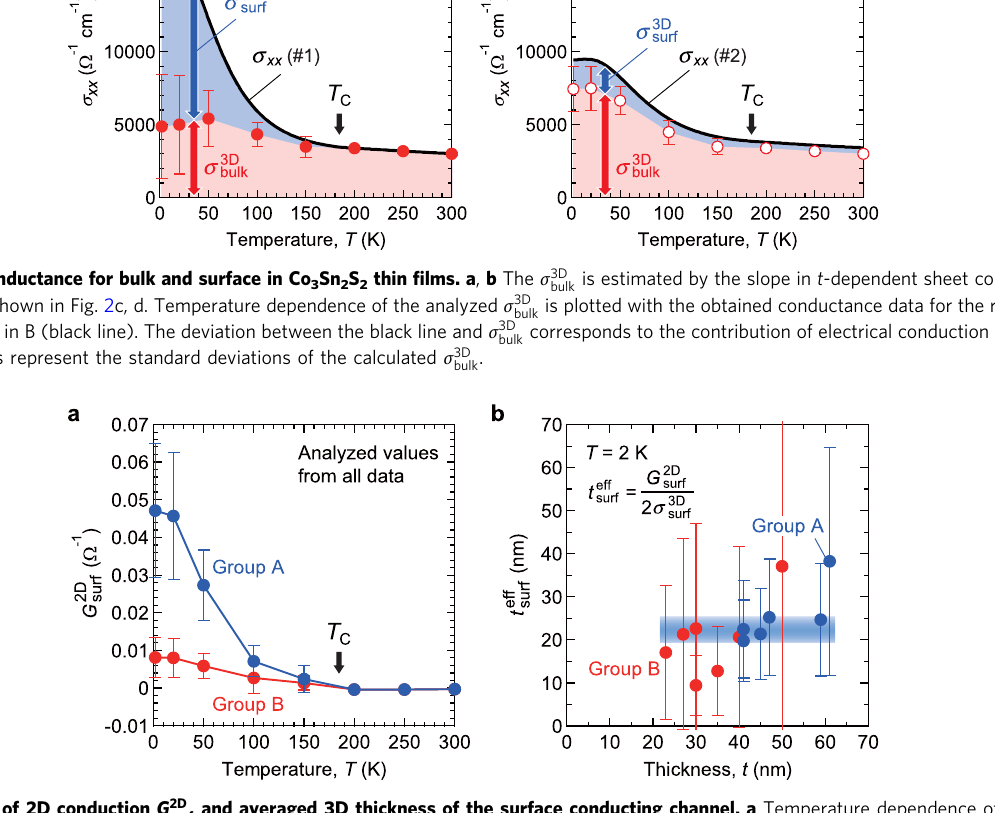
Fig. 4 Comparison of 2D conduction G 2D and averaged 3D thickness of the surface conducting channel. a Temperature dependence of the surface surf conduction G 2D by the analysis as shown in Fig. 2d for the data of Group A (blue) and B (red). b Under the assumption of uniform electrical conduction at surf ¼ G 2D surf the surface region, the effective thickness of surface conduction t eff is calculated by t eff at T = 2 K. The error bars represent the standard deviations surf surf 2 σ 3D surf of the calculated G 2D and t eff in a and b , surf surf